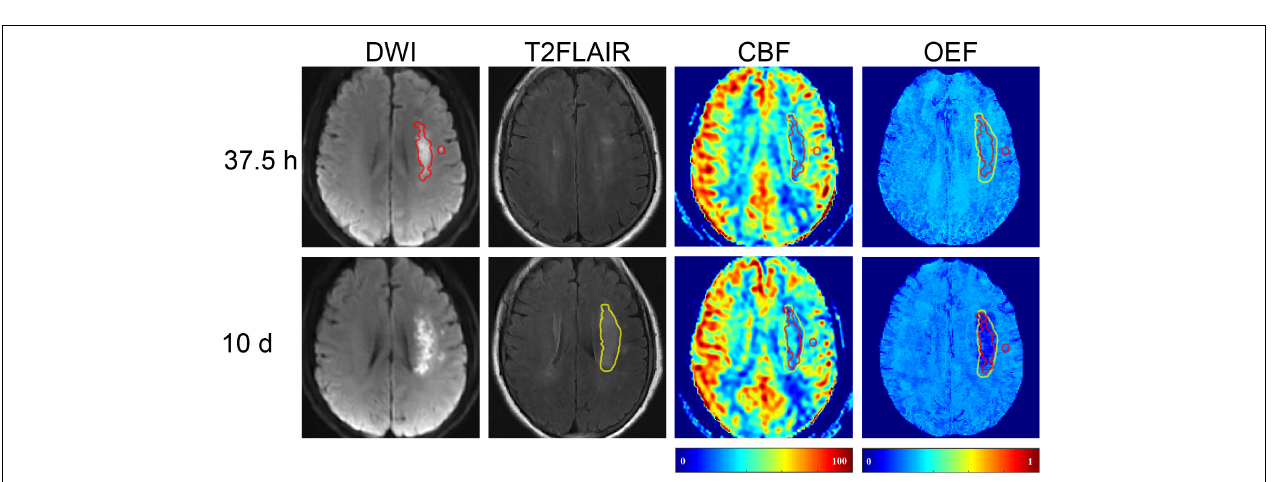
FIGURE 3 | Representative images of a 64-year-old female with right limb weakness and aphasia. The FI (with a volume of 5.31 ml) on 10-day T2FLAIR (shown in yellow) was larger than the 37.5-h IDL (10.97 ml) on DWI (shown in red). The area of FI that did not overlap with IDL was the mismatch. T2FLAIR, T2 fluid-attenuated inversion recovery; DWI, diffusion-weighted